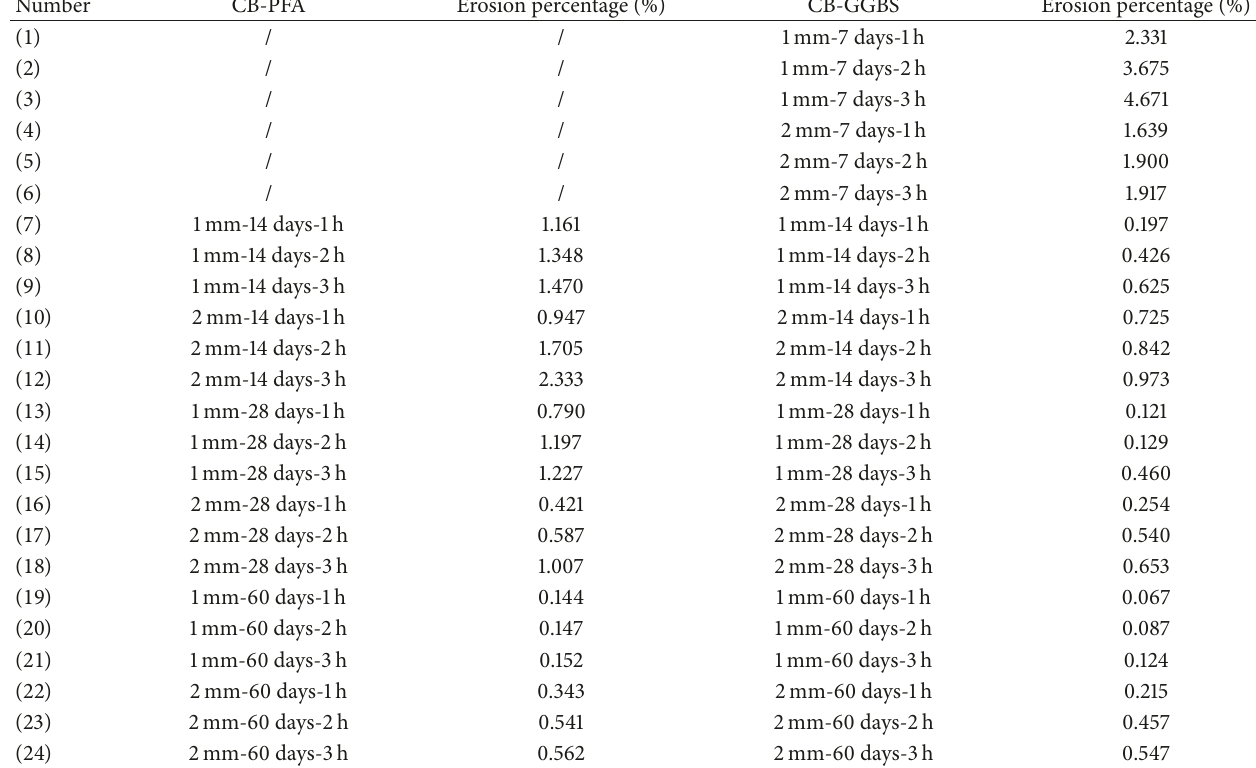
Table 3: Summary of the erosion percentages for the CB-PFA samples and the CB-GGBS